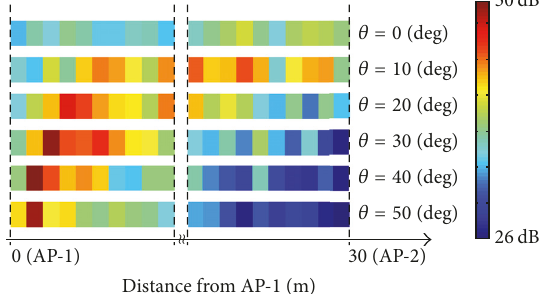
Figure 11: SNR distribution per angle of beam-tilt ( 𝑍 = 8